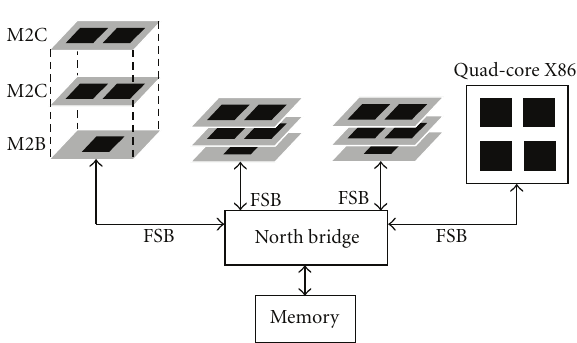
Figure 1: Stacks of Xilinx M2 FPGA modules that can be placed in standard CPU sockets on the motherboard.